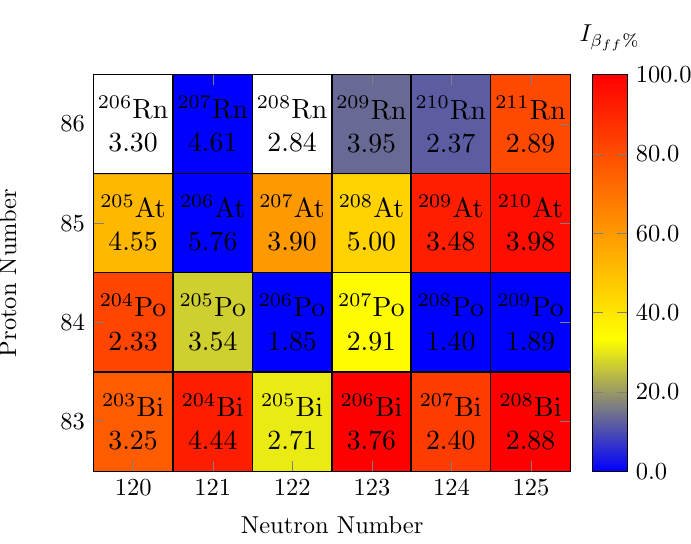
Figure 1. Role of first forbidden decays for nuclei ‘north-west’ of 208 Pb. The colour code refers to the I β FF / I β TOTAL value. The parent nuclei are indicated. Q EC values, in MeV, are also given. Figure modified from